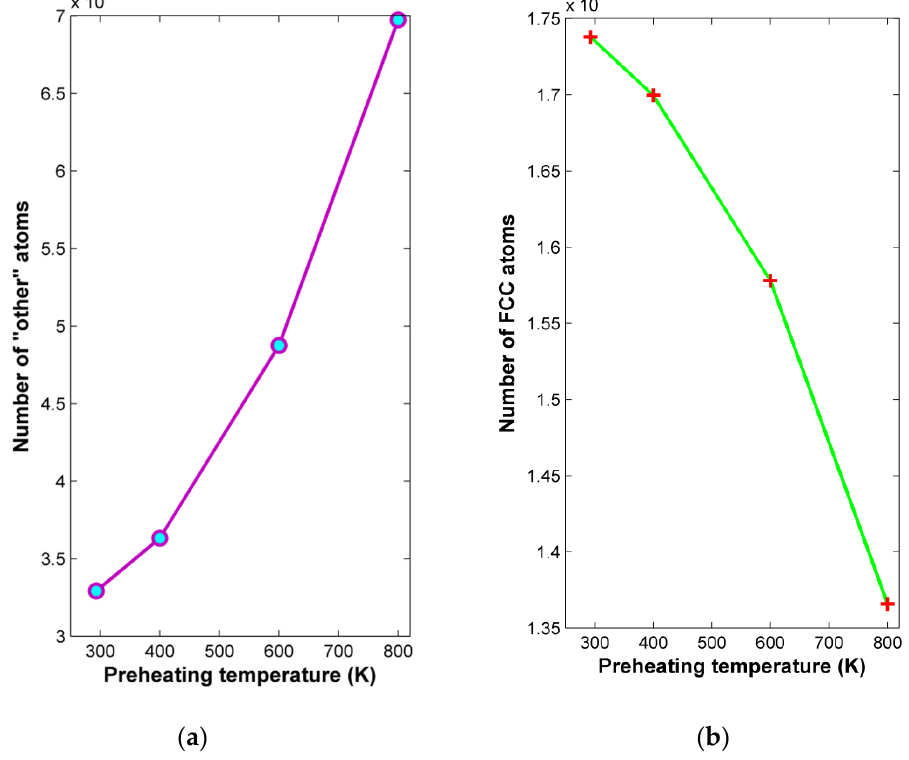
Figure 6. Variation of: ( a ) “other” atoms and ( b ) fcc atoms with respect to preheating temperature.